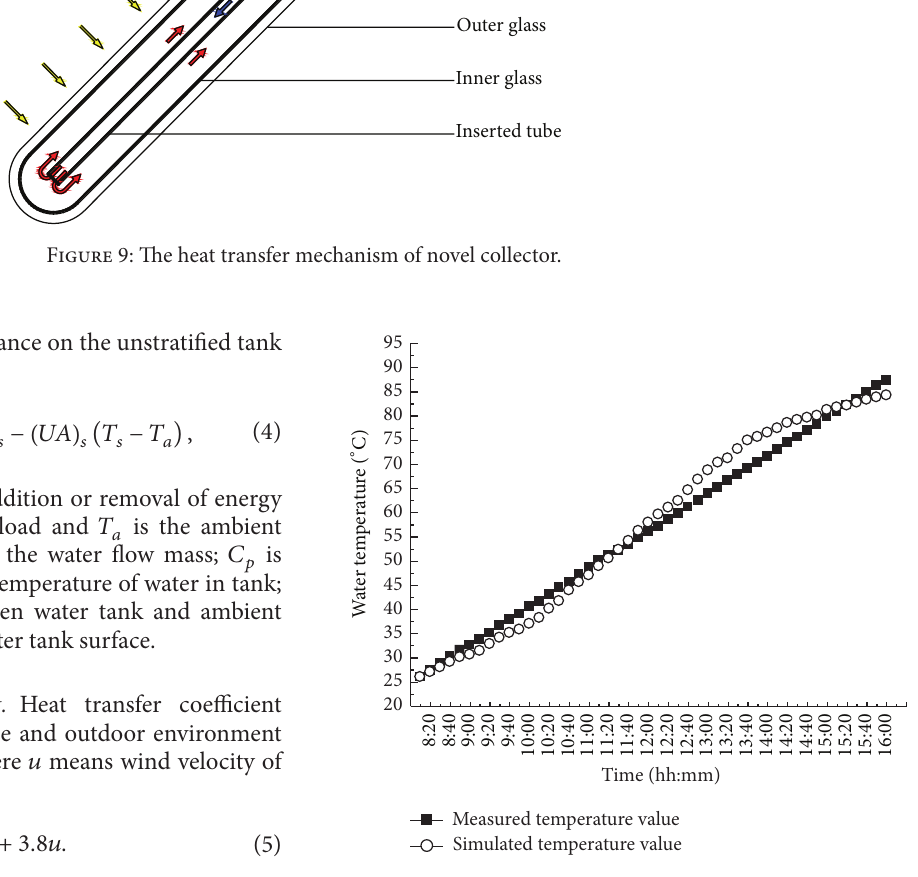
Figure 10: Measured water temperature value and simulated water temperature value versus testing